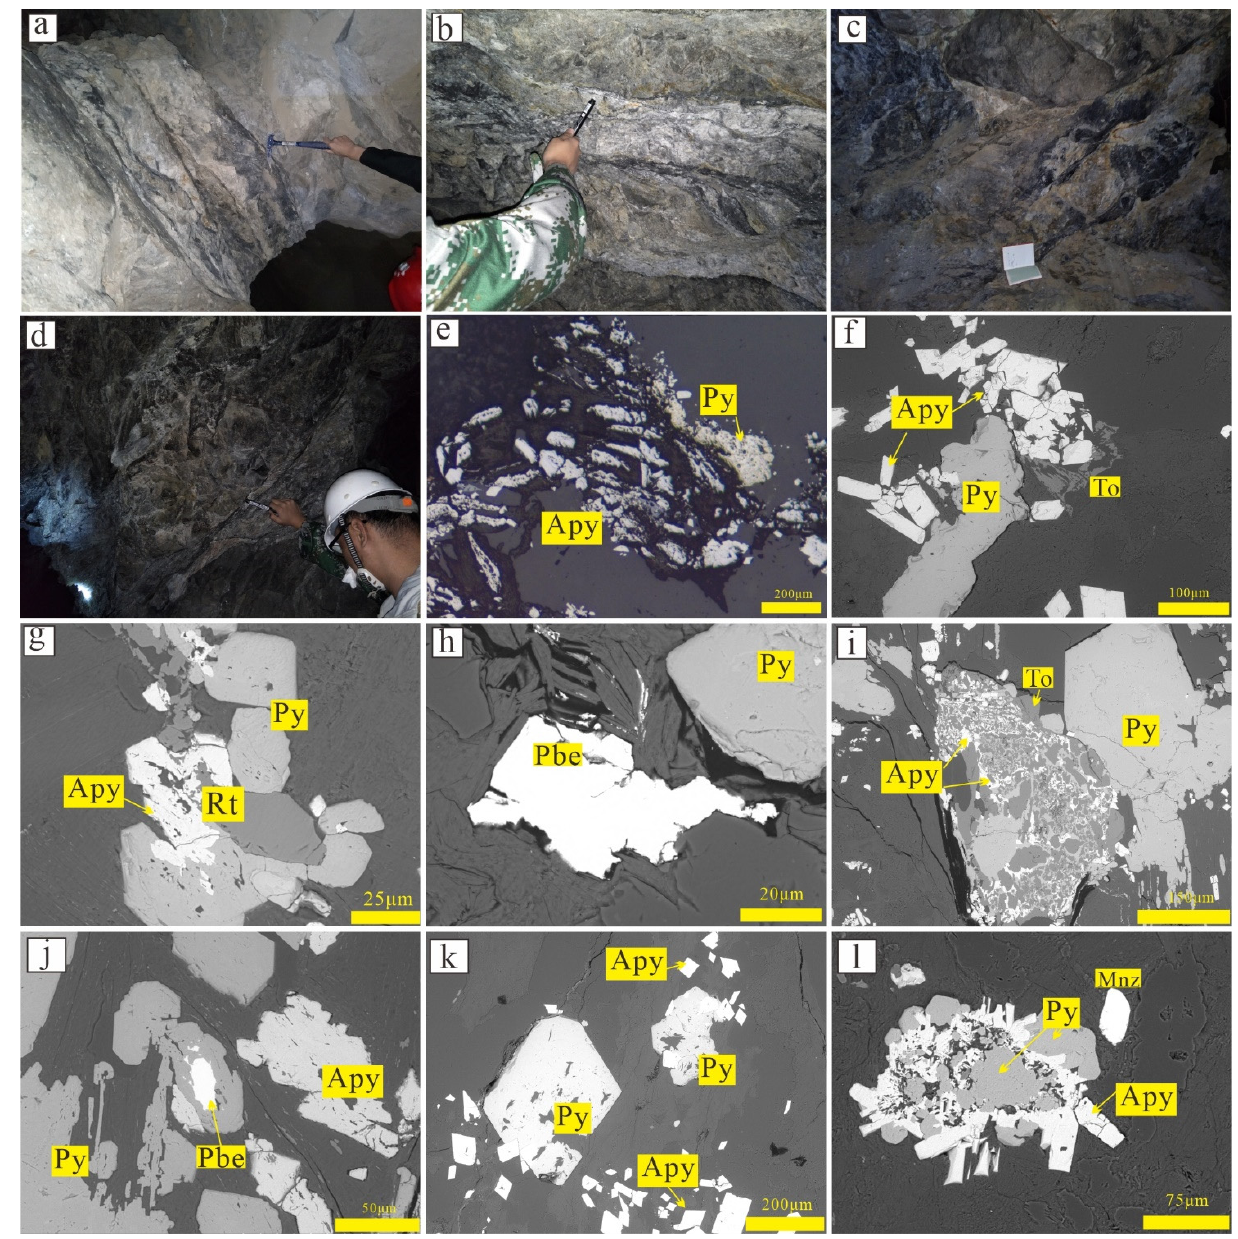
Figure 4. Images of the ore minerals and relationships between pyrite and arsenopyrite in the Yanjingou Au deposit. ( a – d ) field photos: the ore body is controlled by fault structure and is crushed; ( e ) Reflected light images; ( f – l ) Back-scattered electron images. Py = pyrite; Apy = arsenopyrite; Pbe = polybasite.